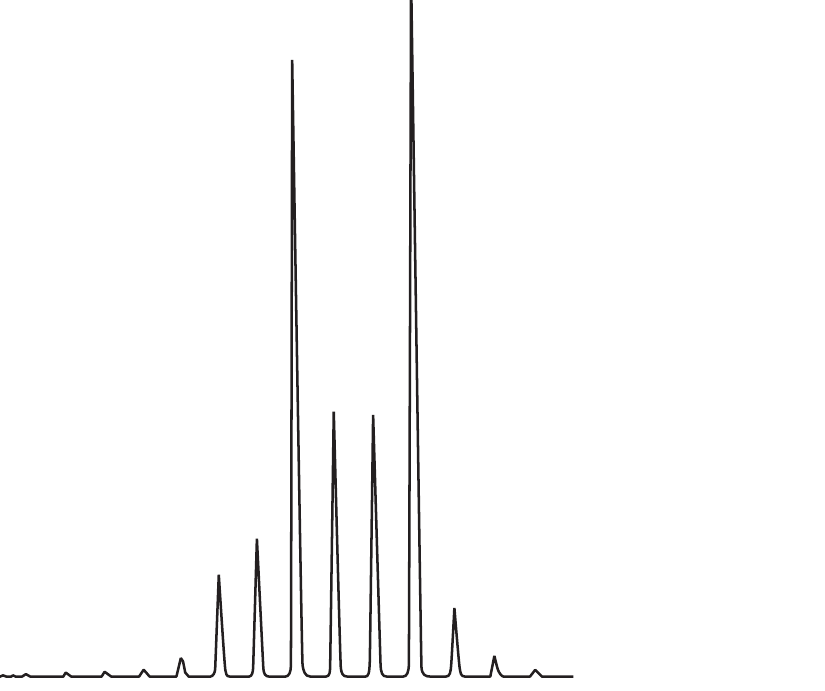
Figure 9. Measured spectral output of a device. Wavelength is along the abscissa and power is along the ordinate. Adapted with permission from Figure 7 of [30] ©The Optical Society.